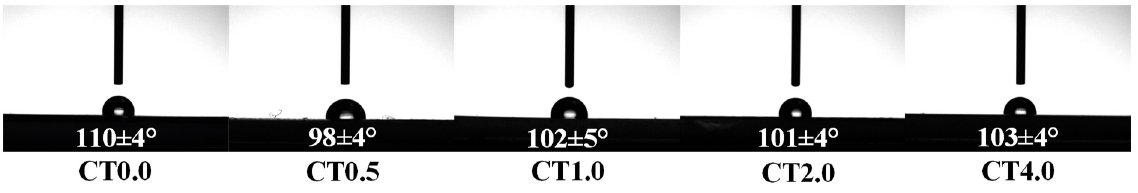
Figure 11. WCA of NIPU Composite Films .